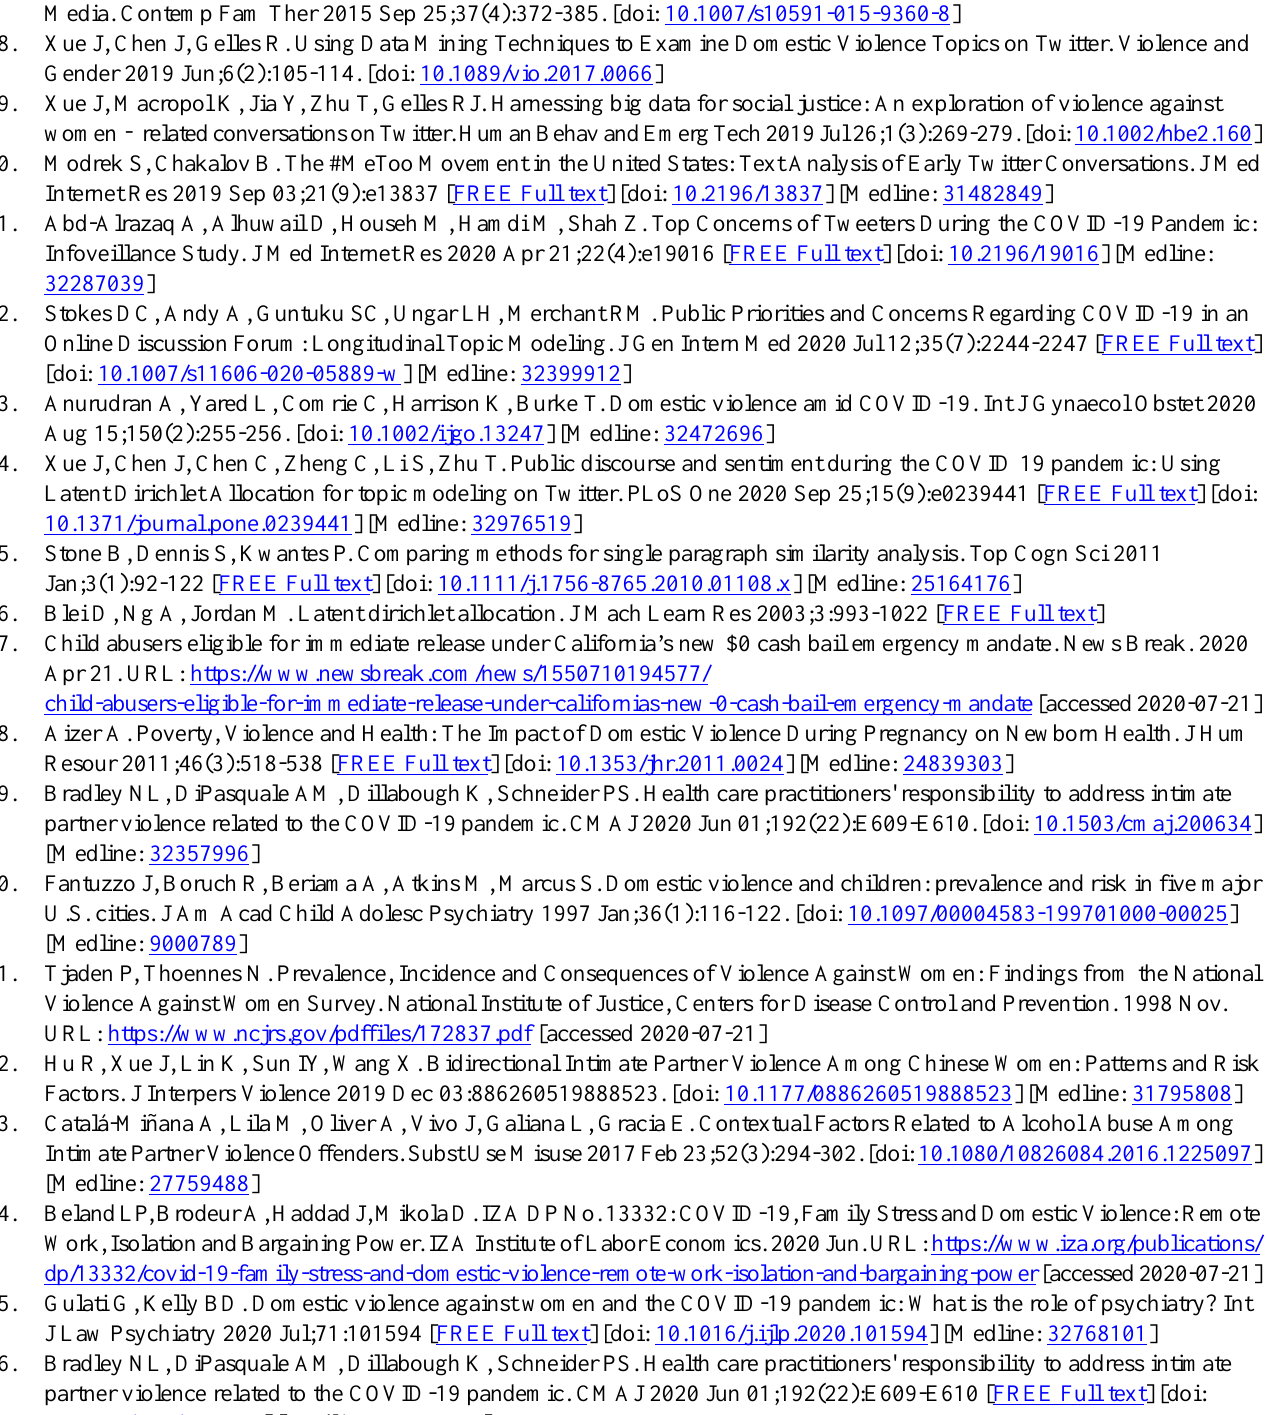
LGBTQ: lesbian, gay, bisexual, transgender, and queer or